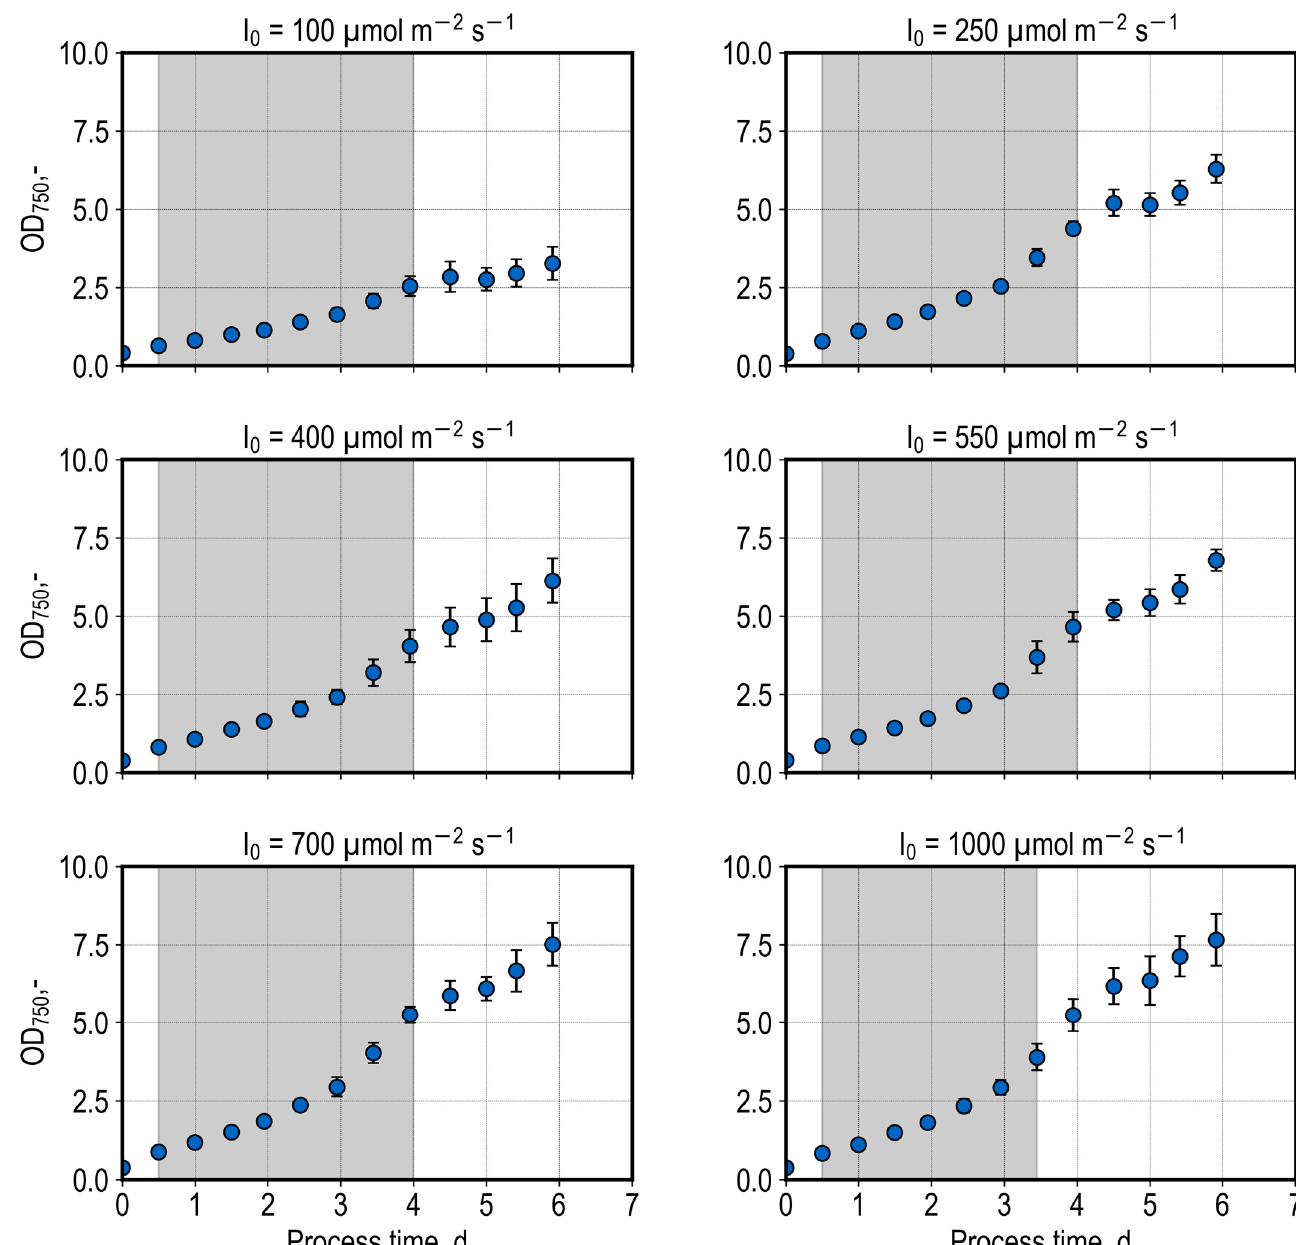
Figure 5. Automated photoautotrophic batch cultivations of M. salina in miniaturized stirred-tank PBRs. Each row of eight bioreactors in the bioreaction unit was illuminated at six different incident light intensities I 0 . Each bioreactor was initially filled with 10 mL of M. salina suspension in an ASW medium with an initial OD 750 of 0.5 (initial pH 8 ± 0.3). Magnetically induced S-stirrers were employed at 500 rpm. The head space of the 48 parallel stirred-tank bioreactors was rinsed with 288 L h − 1 of sterile air with 2% CO 2 . The gray shading indicates the exponential growth phase used to estimate the individual exponential growth rates as a function of the incident light intensities.